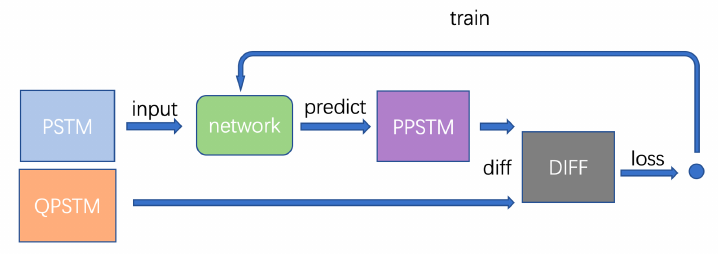
Figure 7. Network workflow for training and prediction. In the training phase, the patches of the PSTM images are fed into the network and the predicted output is determined. Thereafter, the difference between the prediction patches and the actual migration patches obtained using the QPSTM is calculated, and the loss error is back-propagated to update the network parameters to make it more suitable for the training samples. After training for many epochs, the network converges to a fine state, which can be used to predict unseen patches. In the prediction phase, using the well-trained network and the PSTM patch as the input, we can predict the output patch with a high-resolution